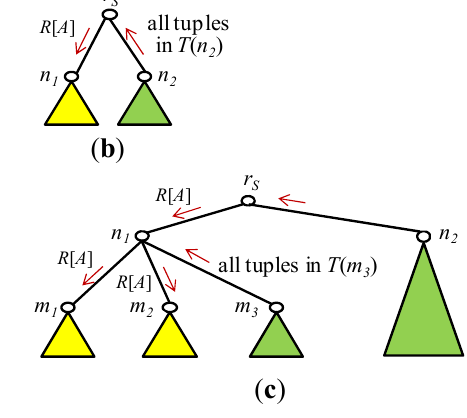
Figure 9. Semijoin R (cid:1673) S in INJECT . ( a ) Relevant portion of the routing tree for an inter-region join R ⋈ S and the shipping of R [ A ] for performing semijoin R (cid:1673) S ; ( b ) Selective forwarding of R [ A ] in PartitionJoin ; ( c ) Recursive application of selective forwarding of R [ A ] in PartitionJoin